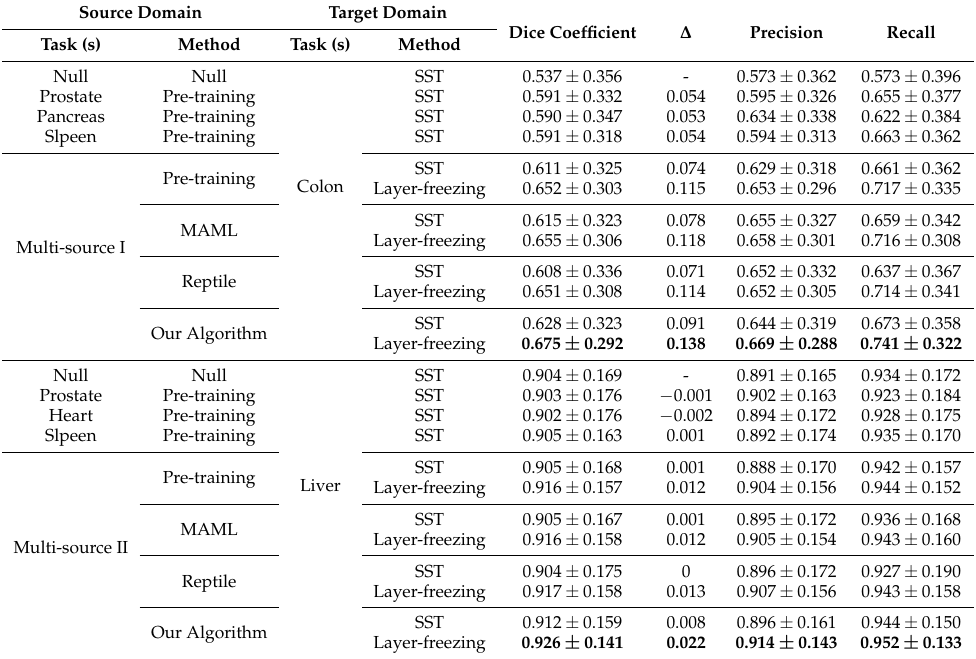
Table 2. The results from two few-shot